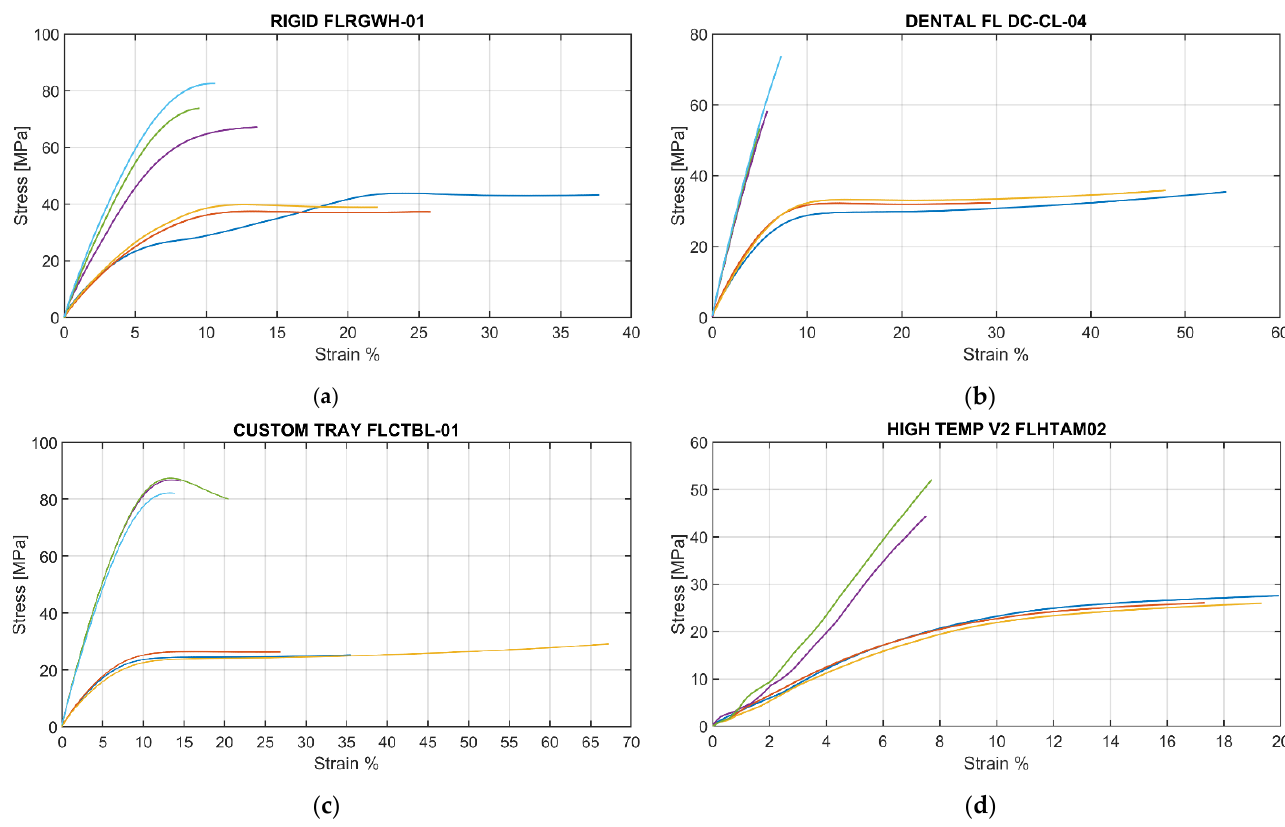
Figure 5. Stress-strain curve green and post-cure of Rigid ( a ), Dental LT Clear ( b ), Custom ( c ), and High Temp ( d ) Resins. Lines are coloured as in Figure 2.